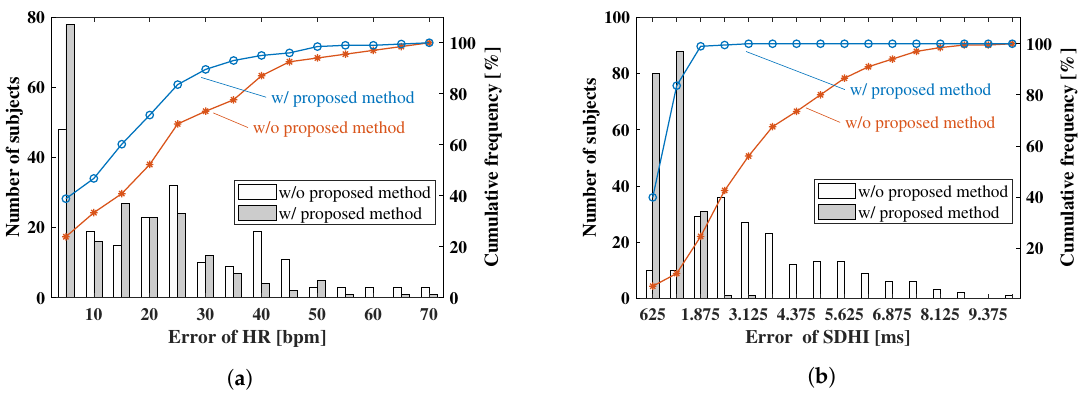
Figure 11. Histograms showing the error of the estimated indices: ( a ) indicates the error distribution of HR, ( b ) represents the error distribution of SDHI.